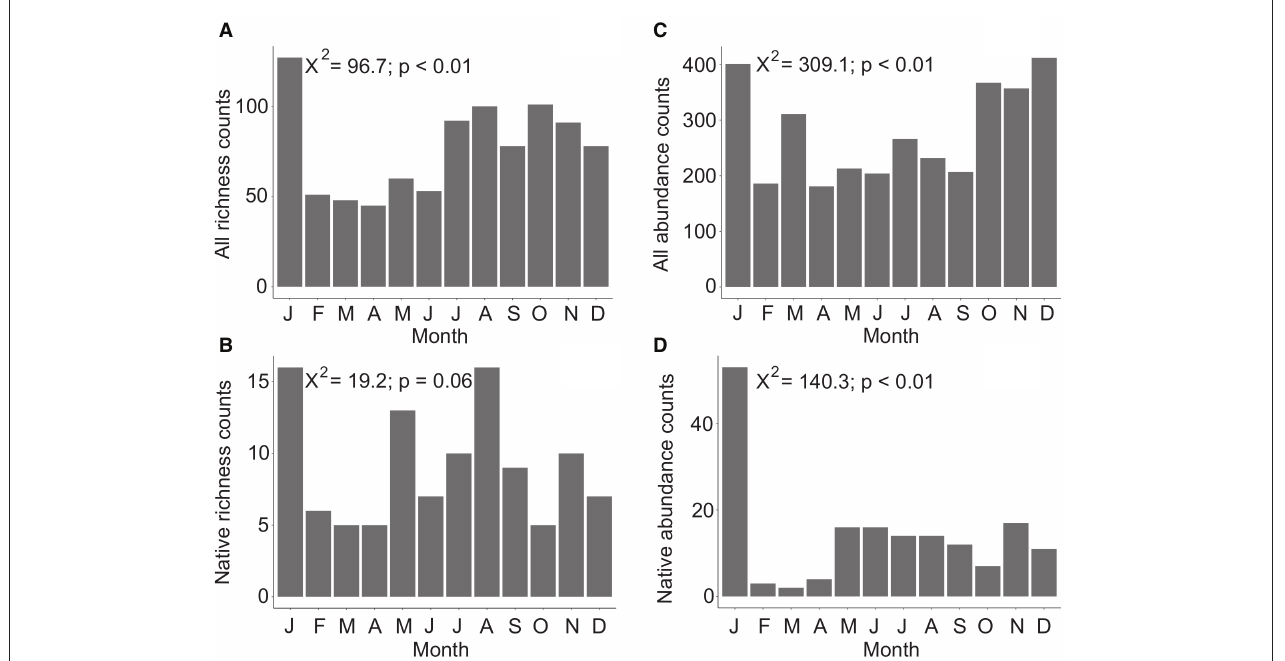
FIGURE 2 | Total species diversity (richness) across 12 months considering all Agaricomycetes included in this study ( n = 321) (A) , and only native species ( n = 33) (B) . Total observations and collections aggregated from online resources (abundance) across 12 months considering all Agaricomycetes ( n = 3,285) (C) , and only native species ( n = 169) (D) . In both datasets, species known to produce long-lasting, persistent basidiomata were excluded. Chi-square values and p -values are indicated in each plot with the null hypothesis being that there is no difference in richness or abundance counts between months.